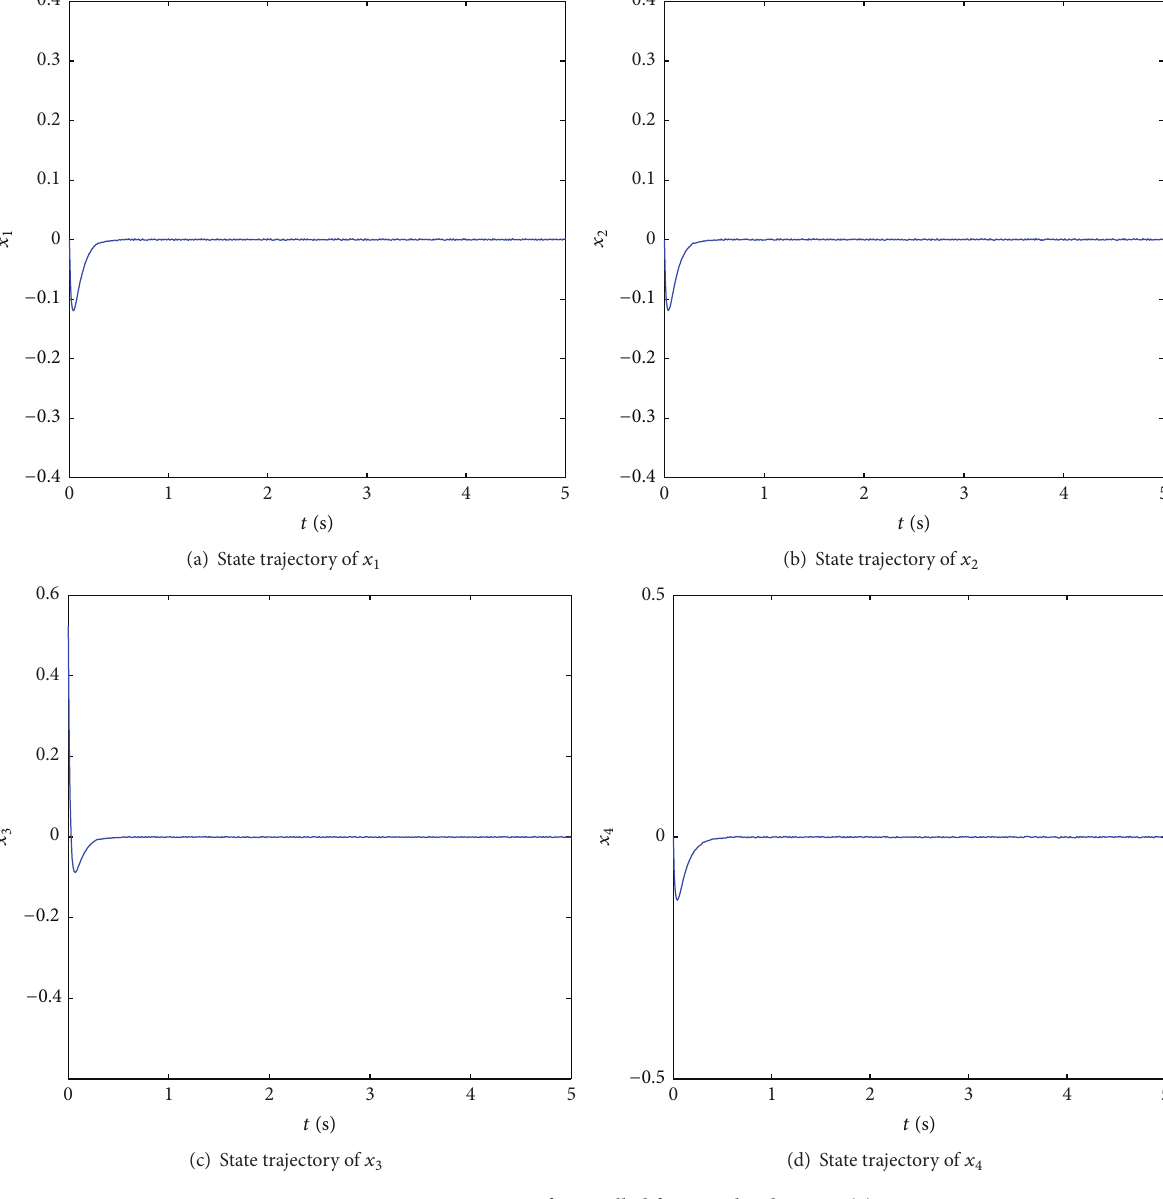
Figure 3: State trajectories of controlled fractional order HGS